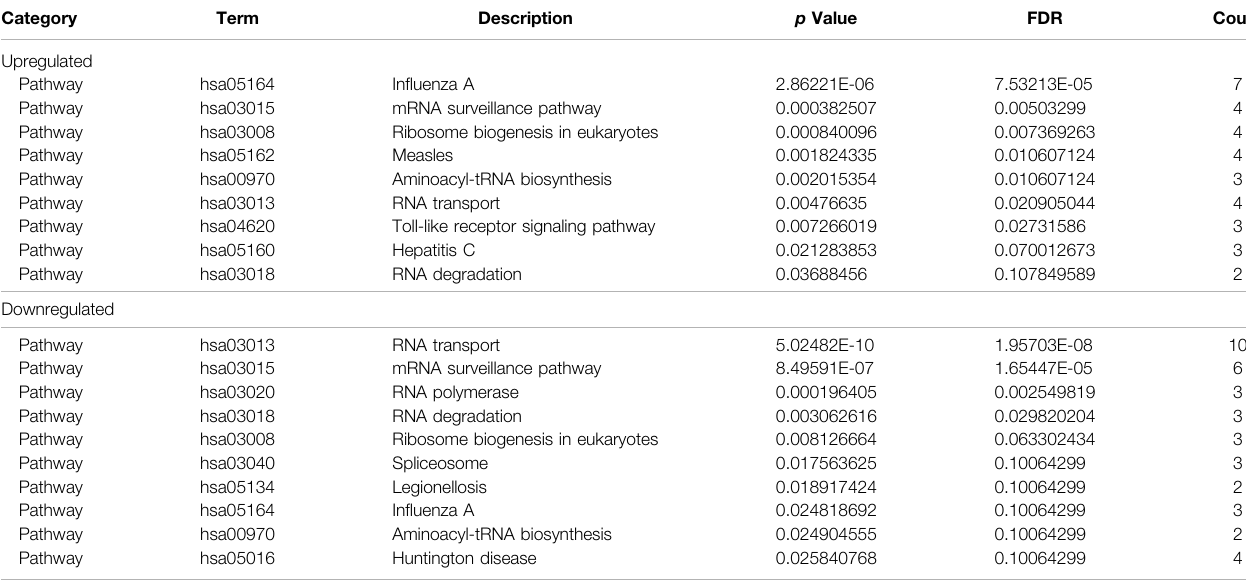
TABLE 1 | KEGG pathway analysis of